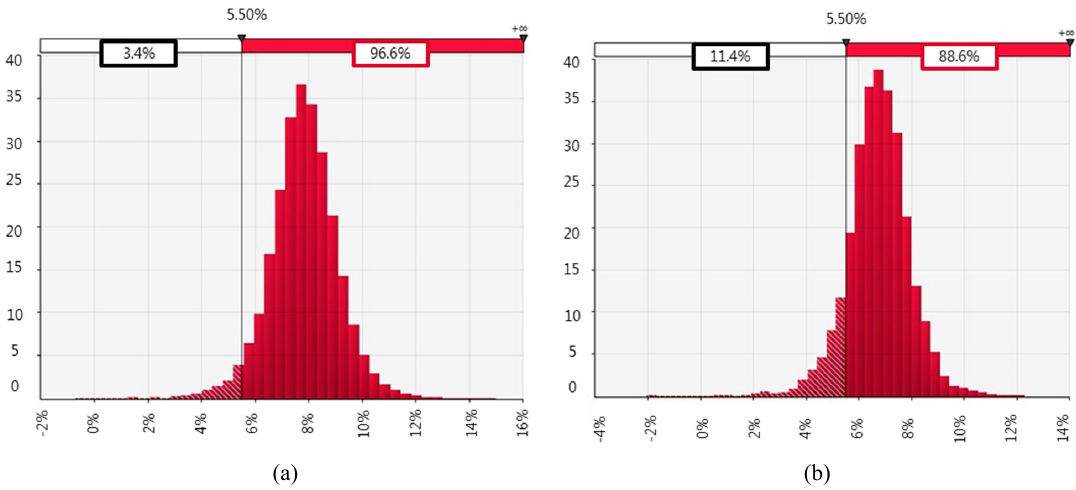
Figure 4. Internal rate of return (IRR) Monte Carlo Analysis ( a ) without SVR and ( b ) with SVR.